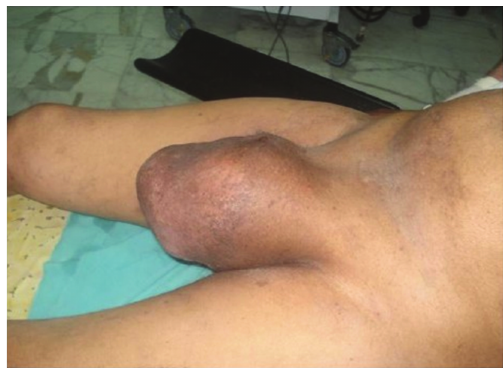
Figure 1: Physical exam: scrotal left mass measuring 20 cm.